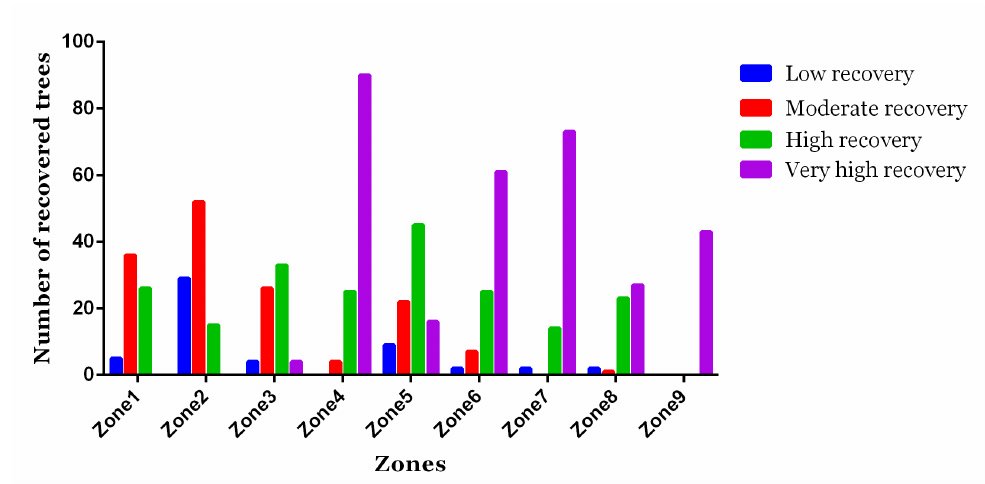
Figure 3. Number of recovered trees in each zone as per recovery class